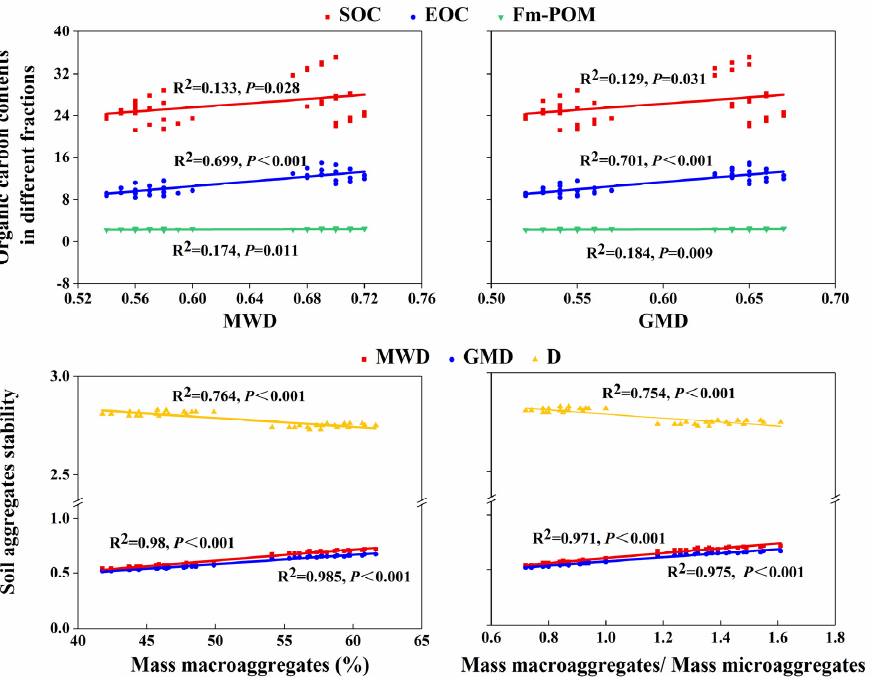
Figure 7. Linear regression equations of the measured parameters. Mass macroaggregates and mass microaggregates represent the proportion of mass distribution in soil aggregates within macroaggregates and free microaggregates, respectively, n = 36. The units of SOC, EOC, OC content of Fm-POM, and MWD are g kg − 1 , mg kg − 1 , g kg − 1 , and mm respectively. The specific meanings of organic matter and organic carbon fractions with abbreviations are presented in Table 1.